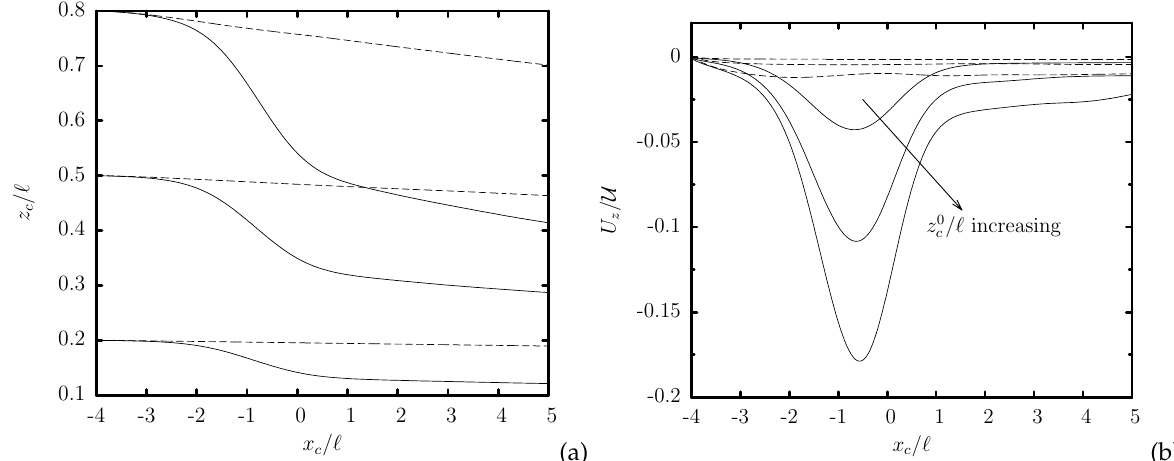
Figure 2. Capsule properties as a function of the centroid x c , for a Skalak capsule with a / (cid:96) = 0.8, Ca = 0.1, C = 1, λ = 1 and initial position z 0 c / (cid:96) = 0.2,0.5,0.8, moving inside a constriction (——) or a straight channel (---). ( a ) Capsule centroid z c , and ( b ) migration velocity U z .